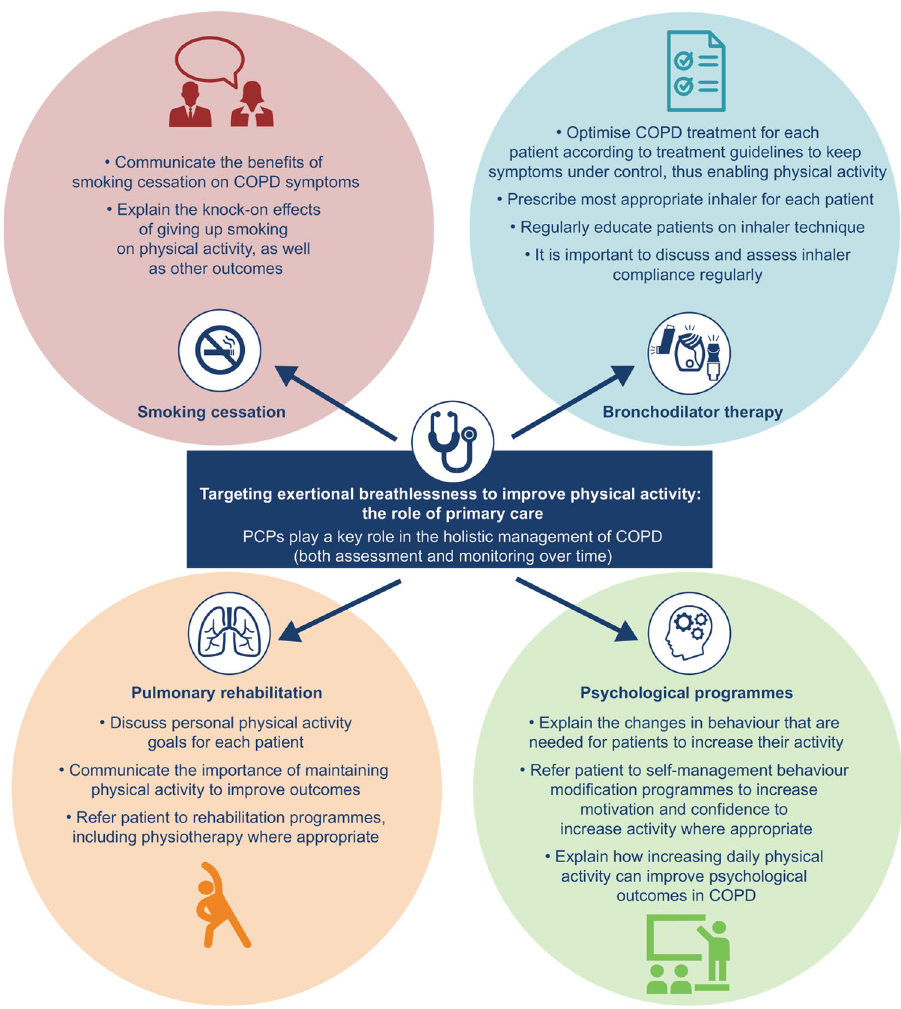
Fig. 2 Targeting exertional breathlessness to improve physical activity: the role of primary care. COPD chronic obstructive pulmonary disease, PCP primary care